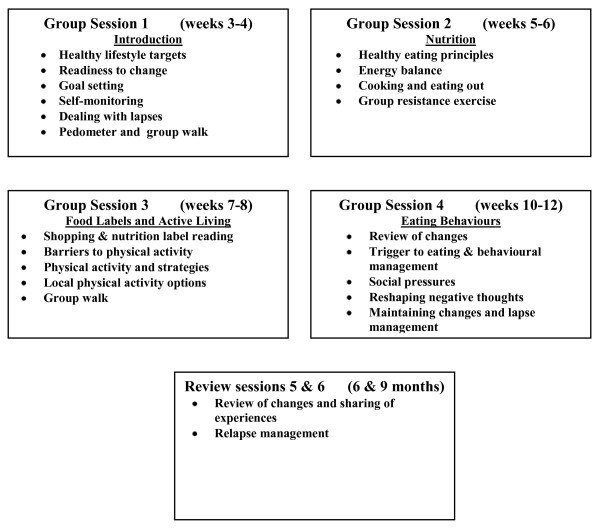
CHANGE for HIPS.